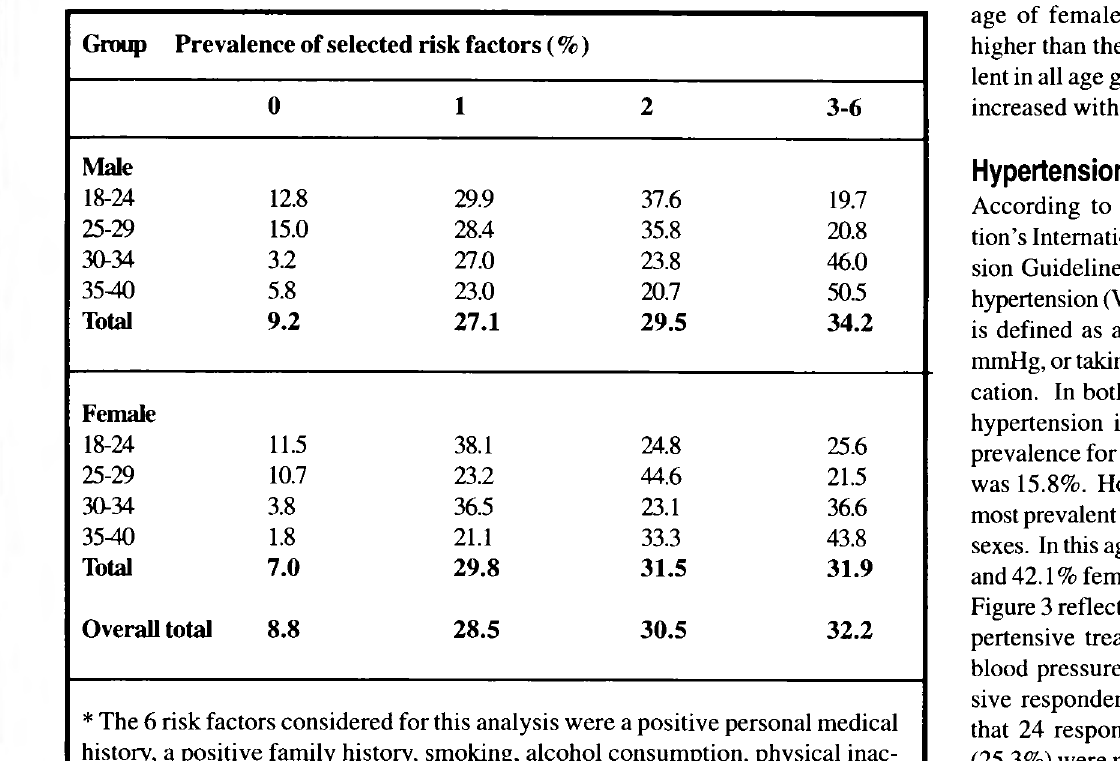
TABLE 3: Prevalence of selected risk factors* for cardiovascular disease